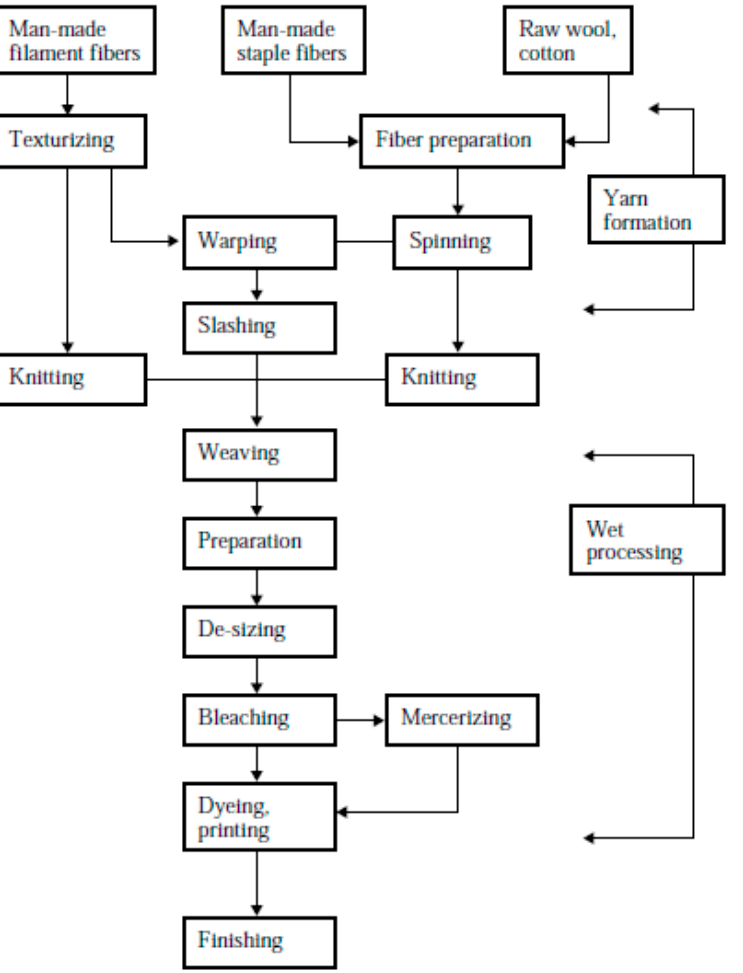
Figure 4. Steps in textile processing in a cotton mill, reprinted with permission from Ref. [3].